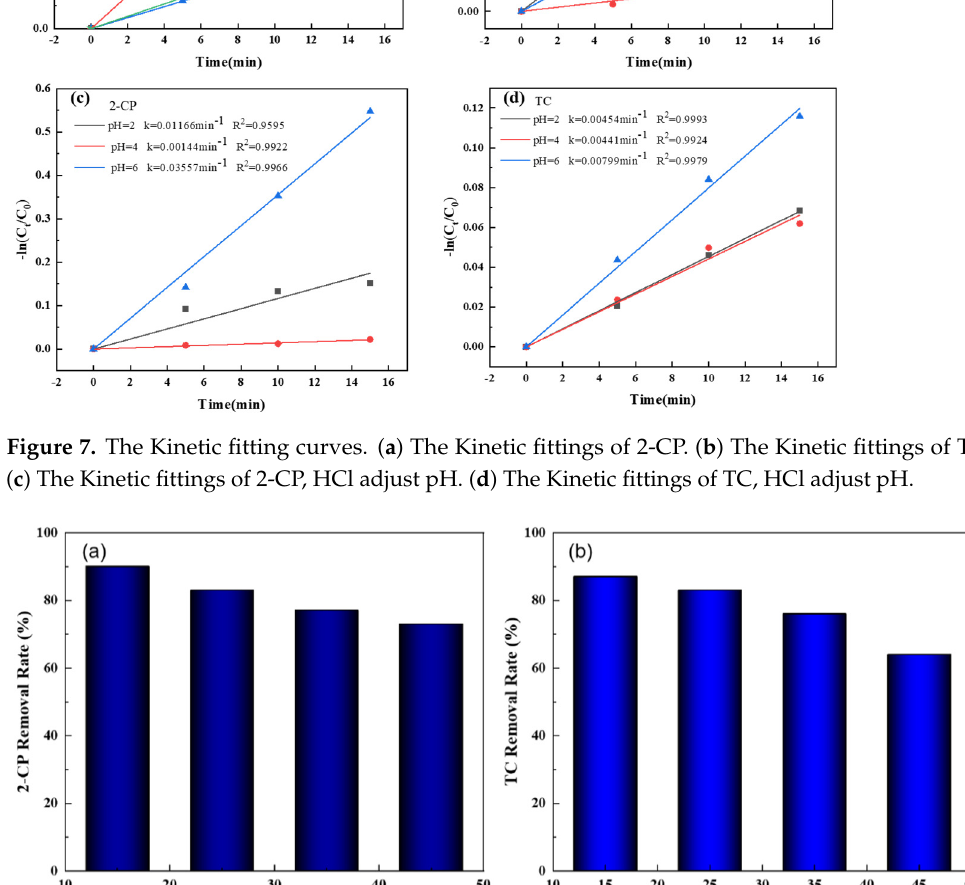
Figure 9. Transient photocurrent responses of catalysts. 2.6. Degradation Properties of Zn 1 − x Cd x S-Activated PMS The optimum photocatalyst Zn 0.8 Cd 0.2 S was selected based on the results of the pre- vious experiments to investigate the degradation in TC and 2-CP with different PMS dos- ages. In this section, different concentrations of PMS were set up for the degradation in TC and 2-CP. As shown in Figure 10a, b, the degradation efficiency of 2-CP increased from 79% to 90% with the increase in PMS dosage, and the best degradation effect and the max- imum reaction rate were achieved when the PMS dosage was 0.02 mM. The degradation efficiency of 2-CP increased from 79% to 90%, and the best degradation effect and maxi- mum reaction rate was achieved at 0.02 mM PMS. According to Figure 10c,d, the degra- dation efficiency of TC increased and then decreased with increasing PMS dosage, and the best degradation effect was achieved at 0.02 mM. The graph shows that when the dos- age is more than 0.02 mM, the degradation process is more obviously inhibited. This may